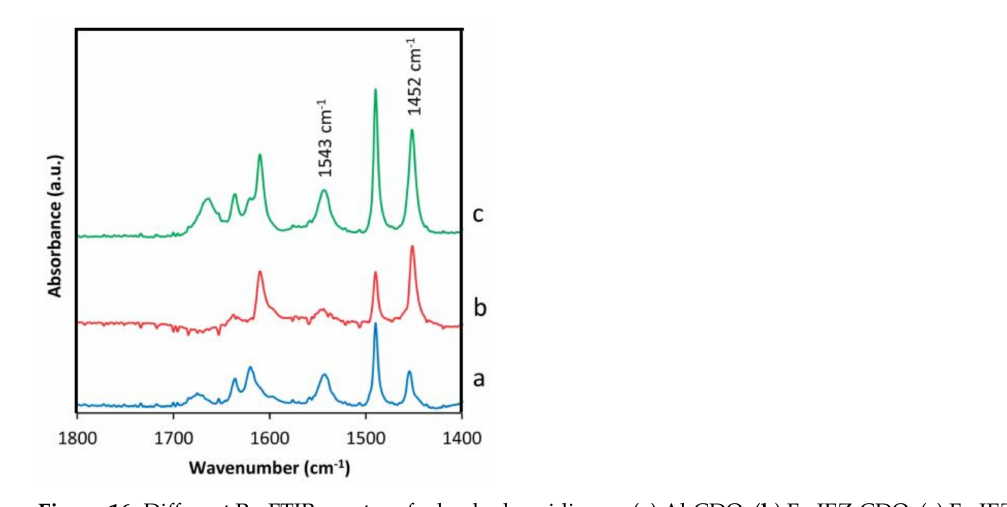
Figure 16. Different Py-FTIR spectra of adsorbed pyridine on ( a ) Al-CDO, ( b ) Fe-IEZ-CDO, ( c ) Fe-IEZ- Al-CDO. Reprinted with permission from ref. [65]. Copyright 2014, The Royal Society of Chemistry.